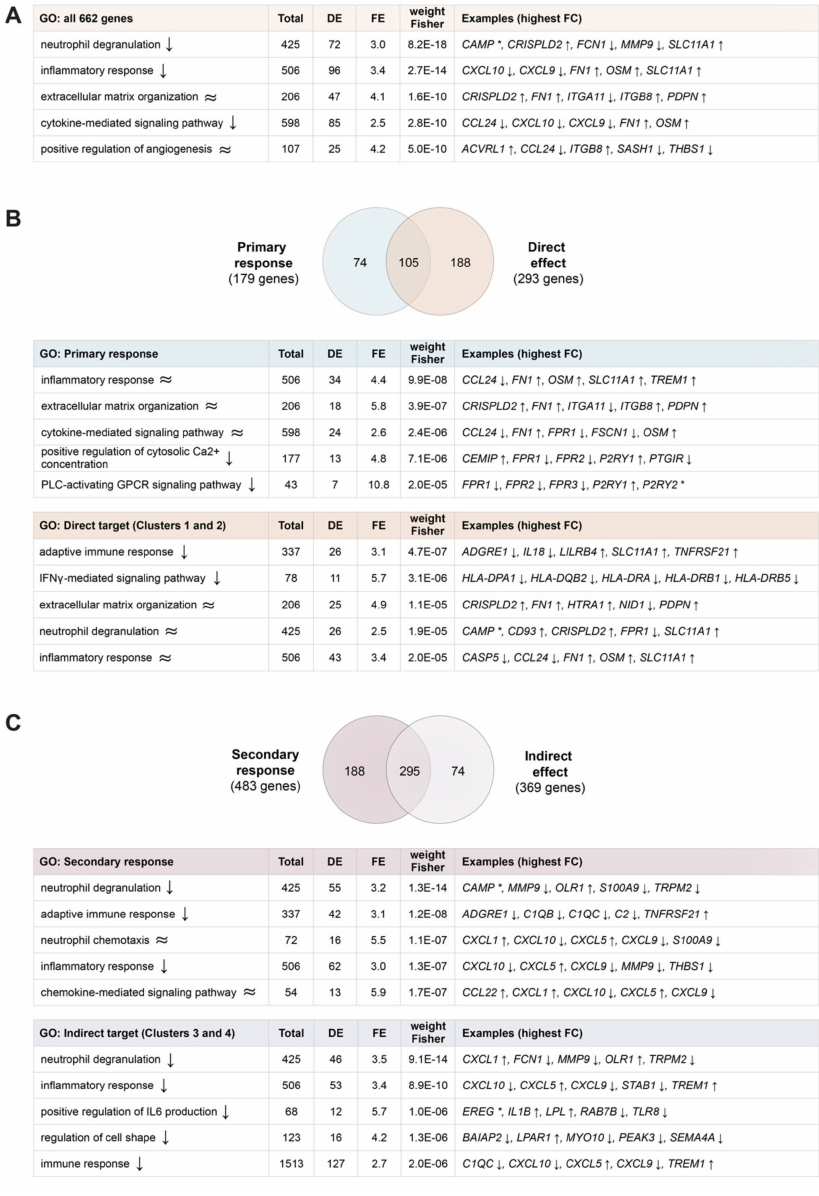
Figure 3. Biological processes affected by vitamin D. GO term enrichment was performed for all 662 vitamin D target genes ( A ), primary and direct targets ( B ) as well as for secondary and indirect targets ( C ). The list of all 12,305 expressed genes served as reference. Venn diagrams indicate the overlap of primary and direct targets ( B ) as well as secondary and indirect targets ( C ). The top 5 enriched terms (ranked by statistical significance) and the corresponding top 5 representative genes (based on absolute median FC) are indicated. The direction of regulation of a gene is based on the FC across all four time points. Asterisks (*) denote genes with mixed FC profiles. Arrows indicate direction of regulation of pathways and target